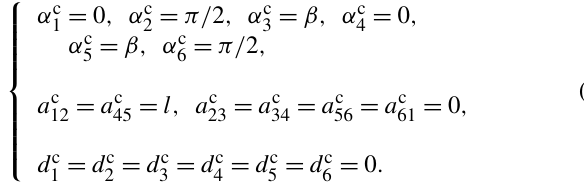
Figure 2. Two types of 4-vertices origami unit cells and the corresponding combined origami patterns: (a) the Miura-ori unit cell, (b) the Bowl-ori unit cell, (c) the combination of two Miura-ori unit cells and their motion pattern, and (d) the combination of two Bowl-ori unit cells and their motion